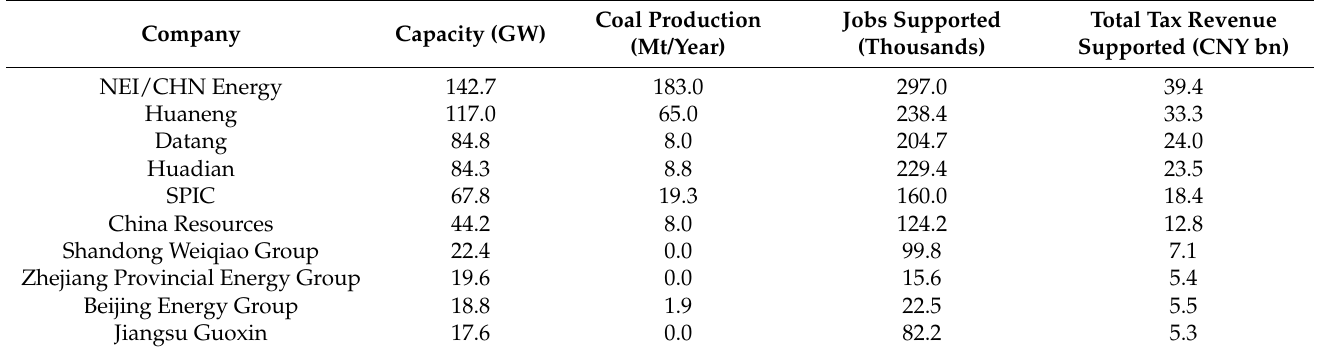
Table 4. Largest 10 companies by capacity (in 2021, B scenario), with corresponding coal production capacity, and jobs and tax revenues supported by each company’s coal